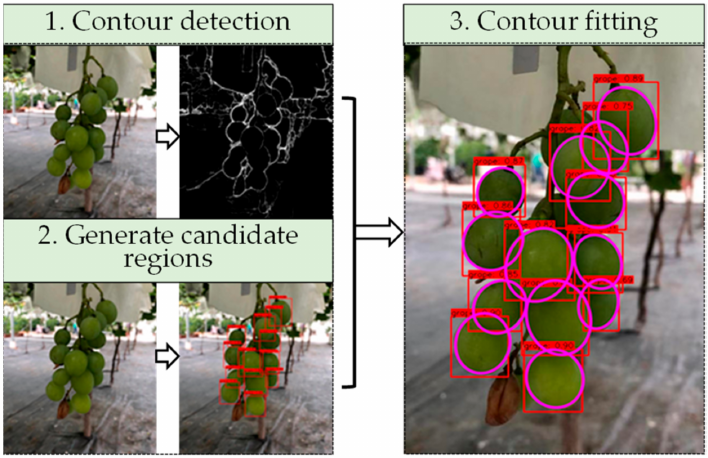
Figure 4. Grape contour fitting